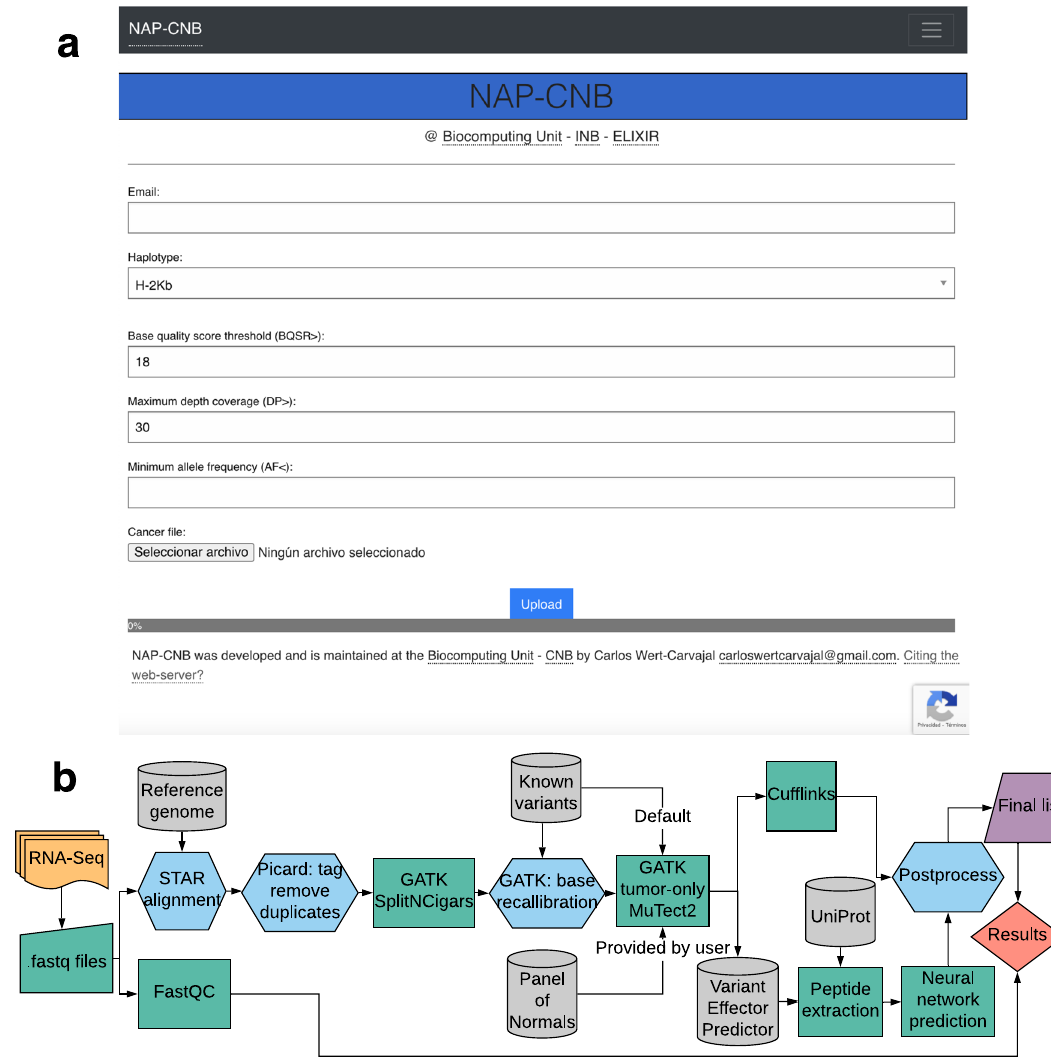
Figure 1. Workflow for the integrated pipeline. ( a ) The user interface of NAP- CNB with the fields required for NGS analysis. Users can introduce filters of GATK for base quality score recallibration (BQSR) of RNA- Seq reads, minimum depth coverage (DP) and allele frequency (AF). Additionally, users may submit peptidic sequences for affinity prediction. Individual submissions are haplotype-specific, and results are sent to an email address. ( b ) Workflow for the integrated pipeline. Firstly, the sample is preprocessed before variant calling. Quality control through FastQC and STAR alignment with the reference genome is followed with protocols from Best Practices of GATK. Known variants are introduced through known polymorphisms or a panel-of- normals if requested, andsufficient non-tumor RNA-Seq reads are provided. MuTect2 is used for variant calling, and plausible single nucleotide variant (SNV) mutations translated into peptidic sequences for prediction with the RNN model. Gene expression is quantified through Cuffquant in